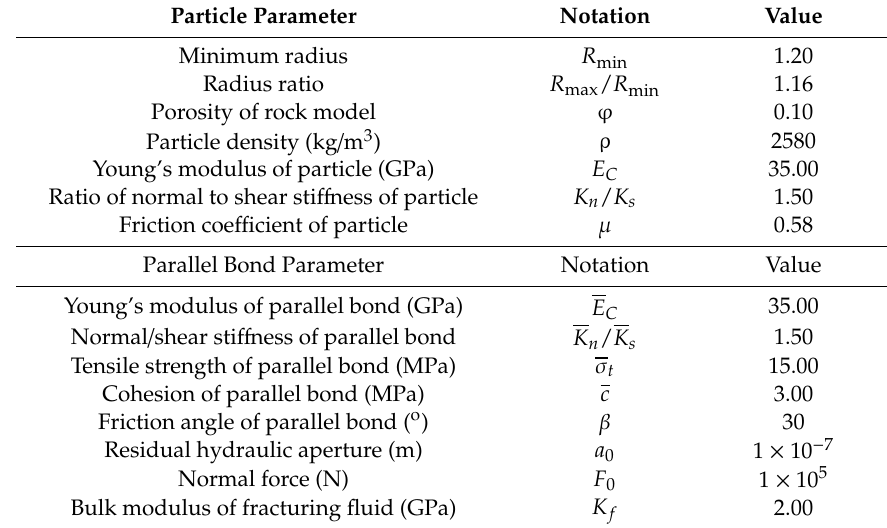
Table 2. Parameters of numerical simulation.